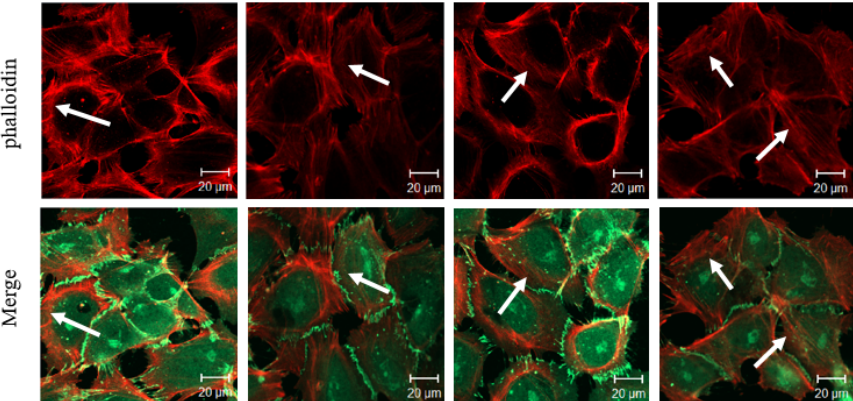
Figure 8. The expression and distribution of VE-cadherin and actin filaments in HUVEC cells under SMG. The upper panel: VE-cadherin stained in green with antibody against VE-cadherin; middle panel: actin filaments stained in red with phalloidin conjugated with Texas Red; the lower panel: merged. The white arrows in the first line show the localization of VE-cadherin. The white arrows in the second line show the localization of F-acting. The white arrows in the third line show F-acting localized beneath adherens junctions formed by VE-cadherin. Scale bar = 20 µ m.